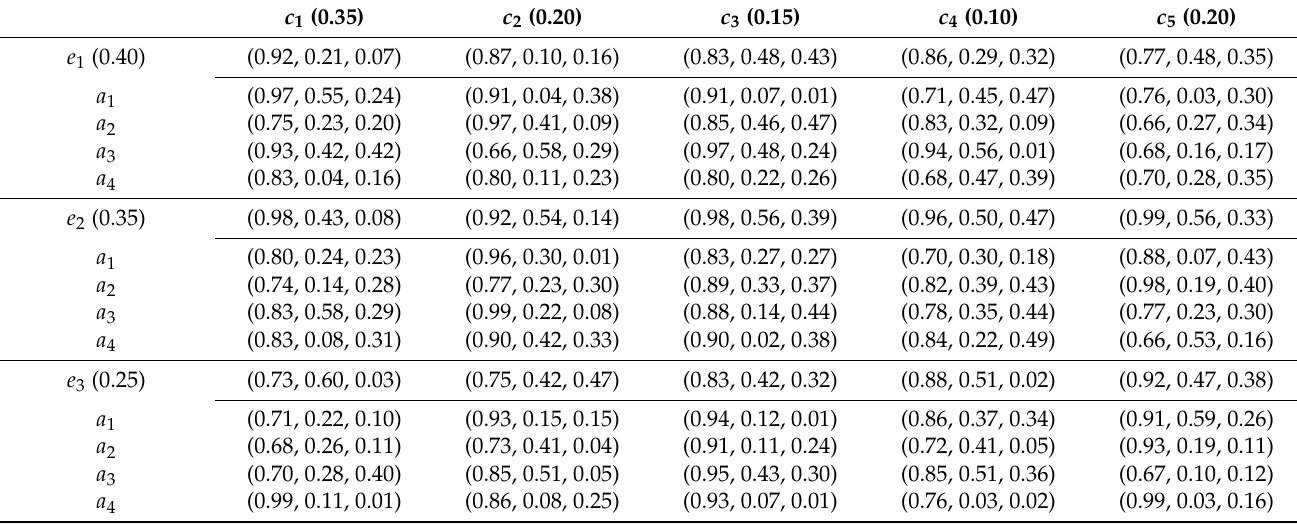
Table 5. CMAGDM information of house